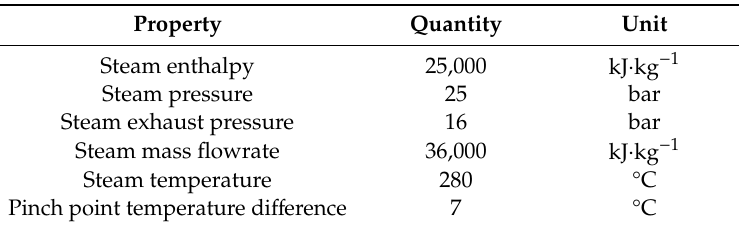
Table 3. Values implemented in the steam system.